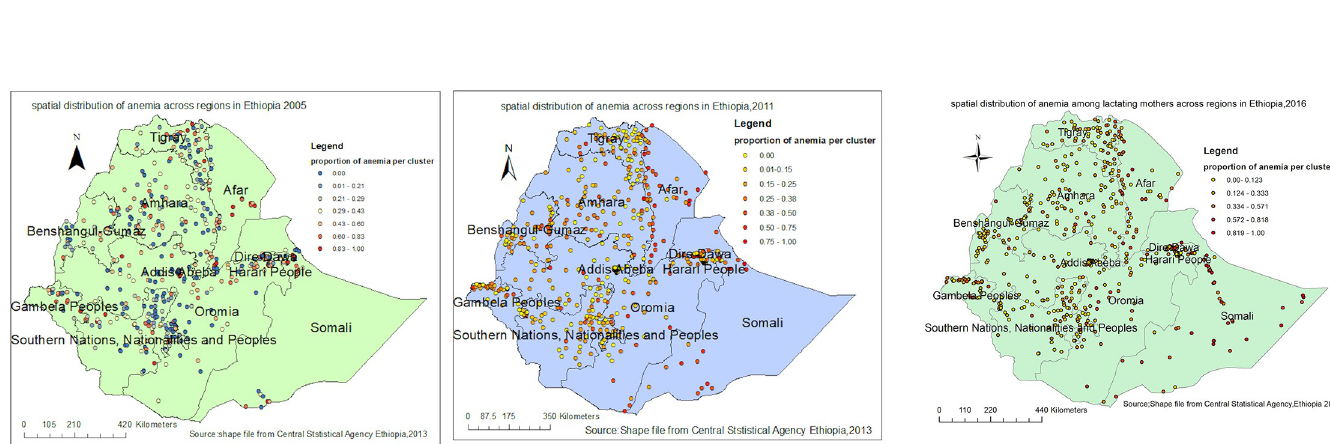
Fig 3. a-c: Spatial distribution of anemia among lactating mothers in Ethiopia 2005 (a), 2011 (b), 2016 (c) EDHS (Source: Shapefile from Central Statistical Agency, Ethiopia, 2013).